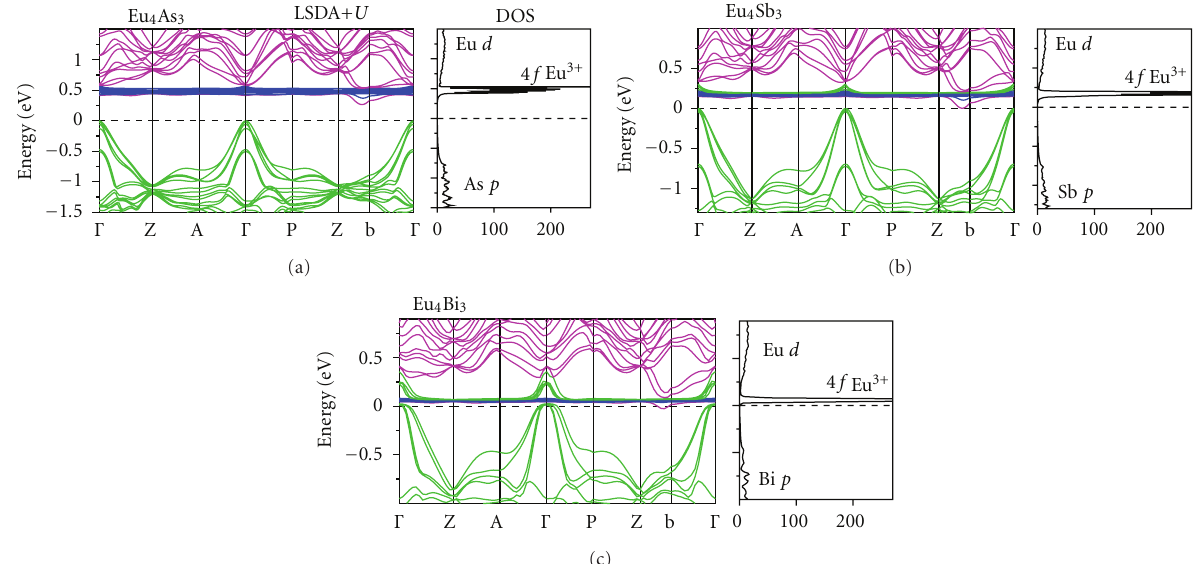
Figure 85: The energy band structure and total DOS (in states/(cell eV)) of Eu 4 As 3 , Eu 4 Sb 3 , and Eu 4 Bi 3 calculated in LSDA+ U approxima- tion ( U = 7 . 47, 7.35, and 7.25 eV, resp.)